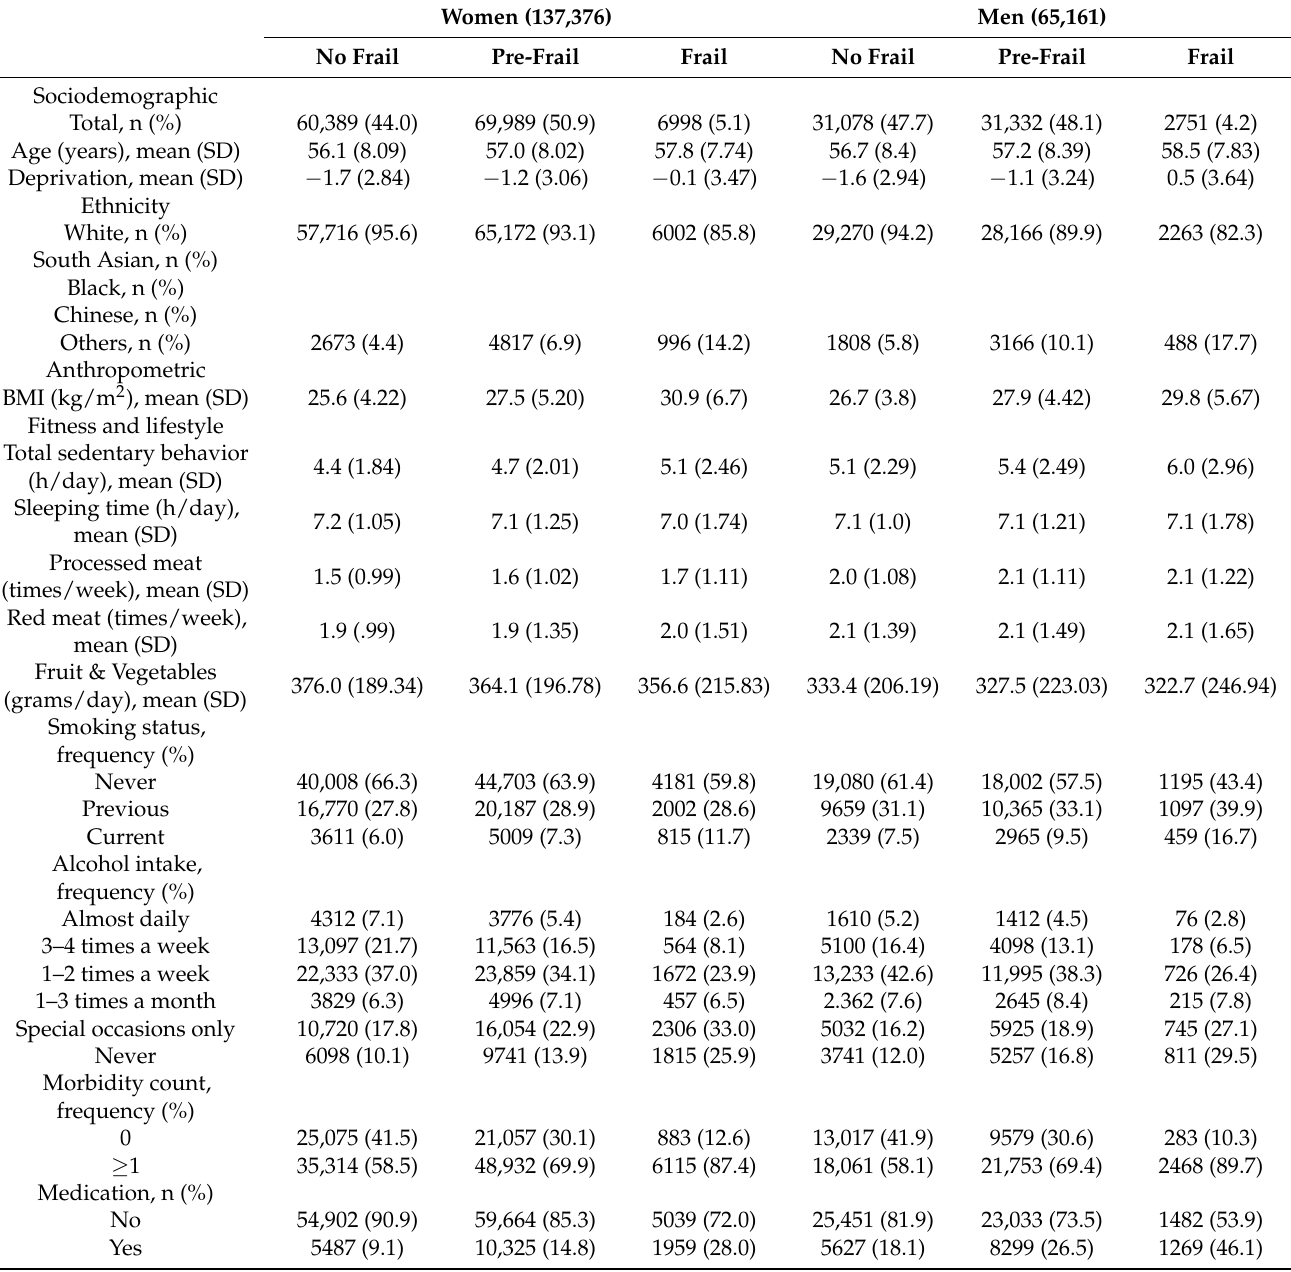
Table 2. Baseline characteristics by sex and frailty